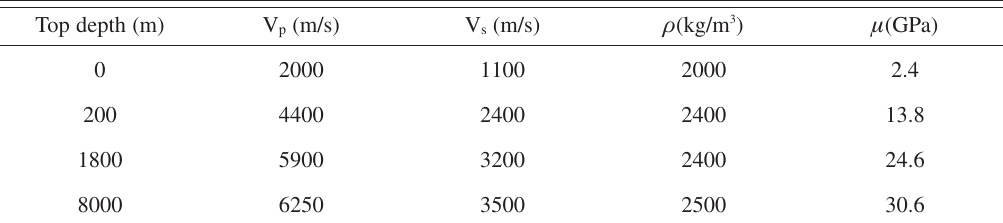
Table II. Crustal model reported by Emolo and Zollo (2001) and used by Capuano et al. (2000). The rigidity modulus is indicated with µ . Top depth